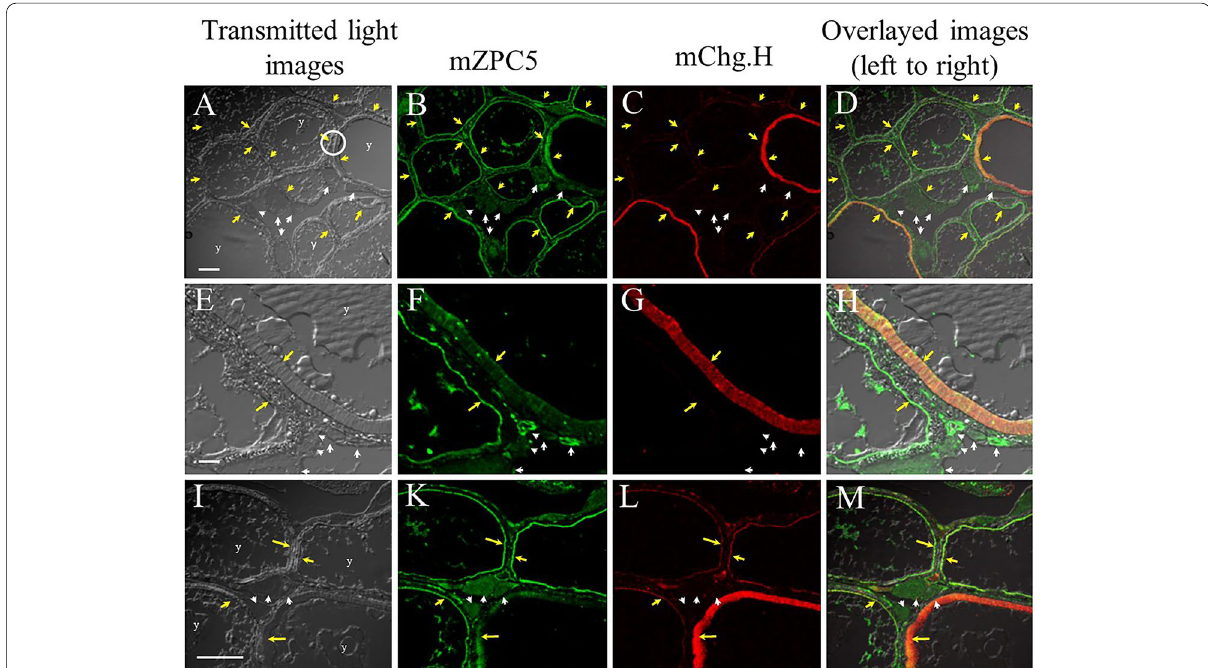
Fig. 6 Immunohistochemical detection of mZPC5 in the ovaries using anti-mZPC5 and anti-Chg.H antibody. All images in the same row show the same tissue section. The first three columns (left to right) show the tissues under different microscope light settings, while the last column shows images from columns one, two and three overlaid. A, E, and I: transmitted light images of oocytes in the ovaries of sexually mature females. B, F, and K: the portions of the tissues reacted with the anti-mZPC5 antibody (green). C, G, and L: the parts of the tissues reacted with the anti-Chg.H (positive control) antibody (red) in the same ovarian oocyte as A, E, and I, respectively. The white-circled area in Fig. 6A was magnified 2.5 times in Fig. 6E–H to visualize structural details in the developing chorion and ovarian oocyte. Symbols – y: yolk, yellow arrows: the position of the chorion, white arrows: early developed oocytes. Scale bars in A, E, and I represent 100, 40, and 100 µm, respectively. The developing stage of oocytes was determined following guidance from Iwamatsu et al., 1988